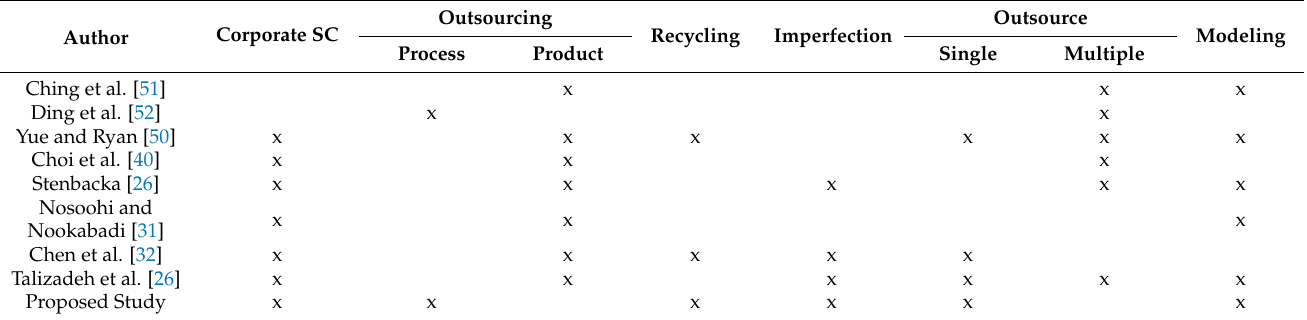
Table 1. Authors